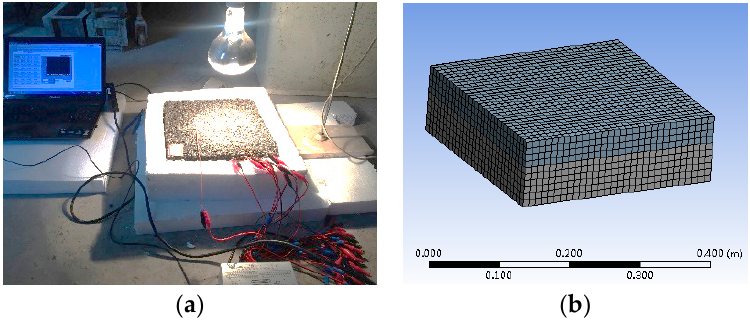
Figure 3. Sunshine experiment: ( a ) laboratory experiment; ( b ) finite element model.